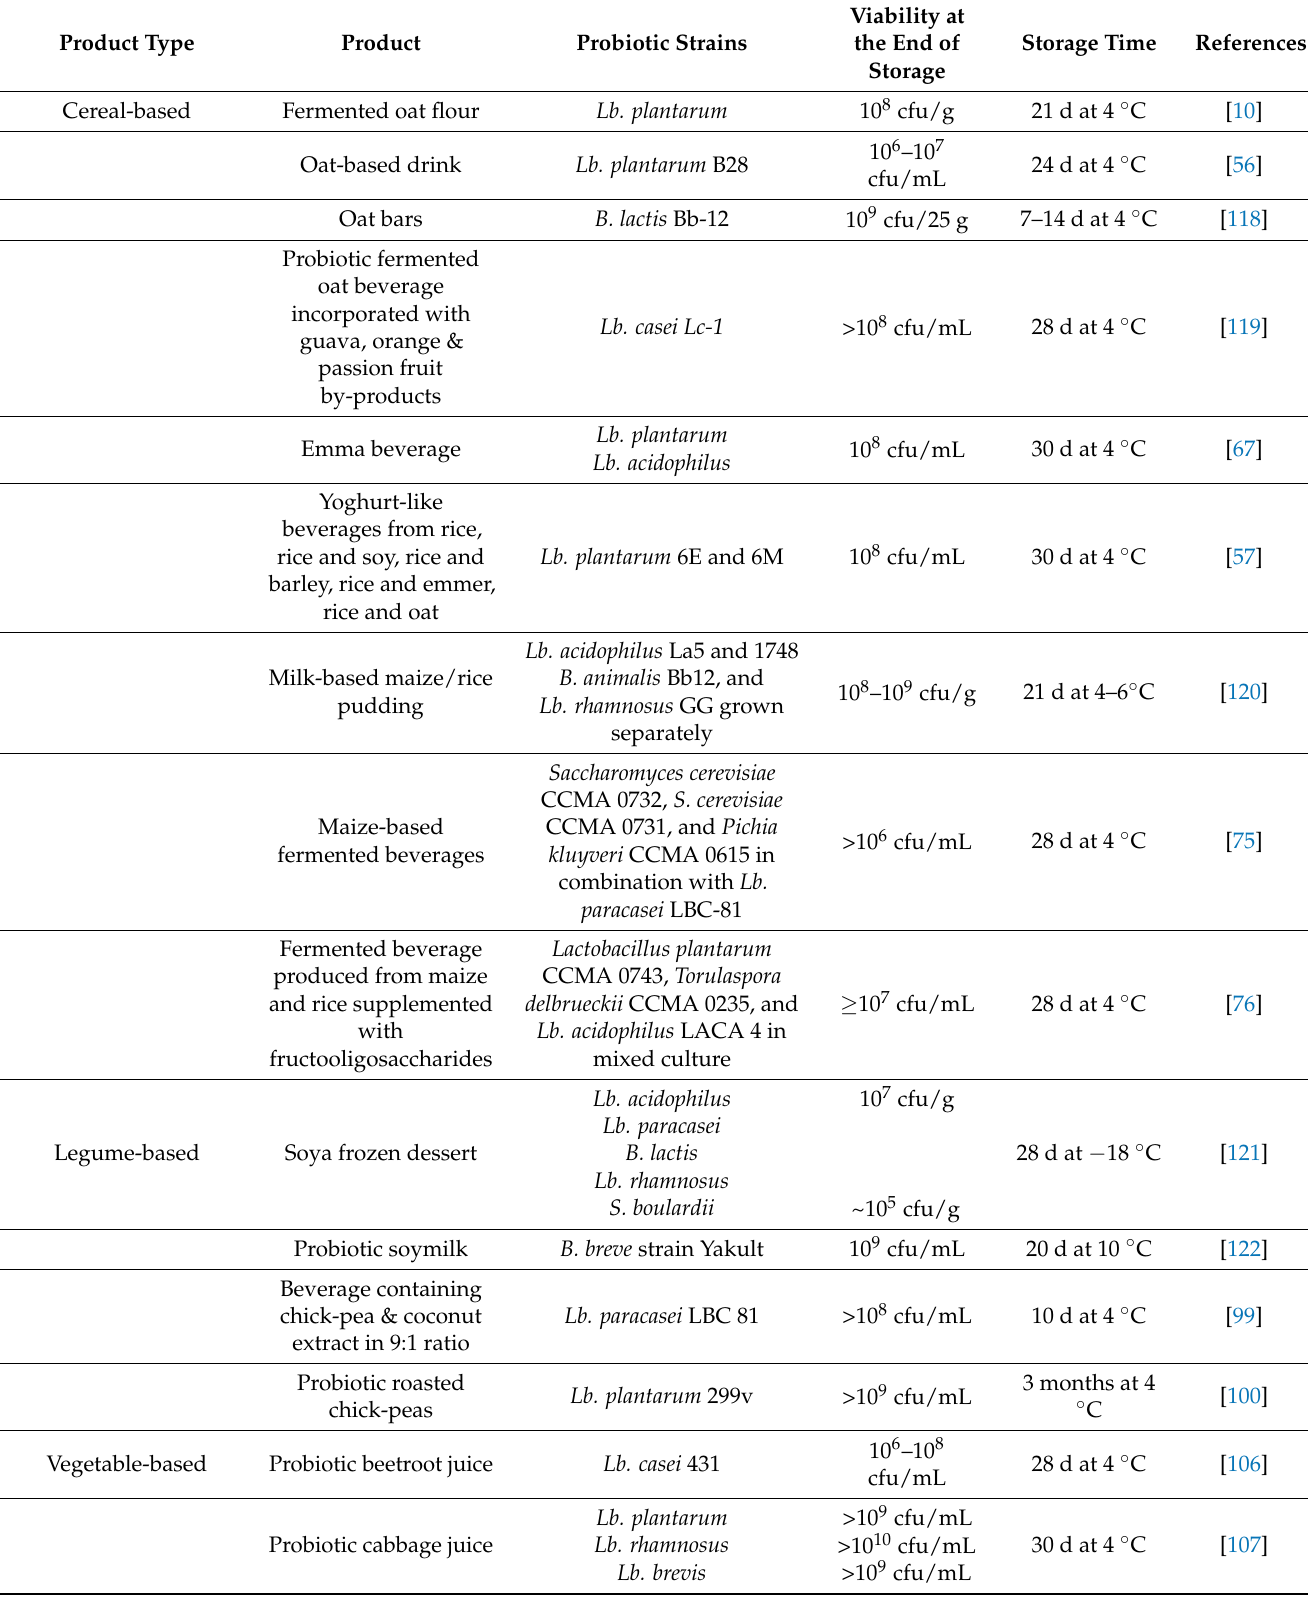
Table 2. Viability of probiotics in non-dairy probiotic products at the end of the storage